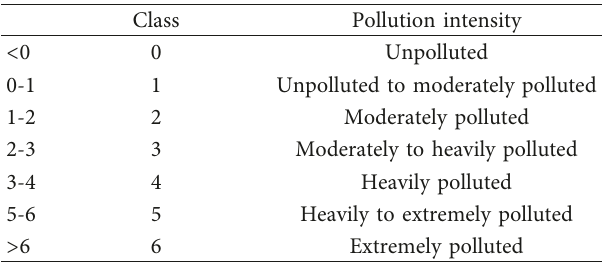
Table 1: Classification of pollution intensity as proposed by M¨uller